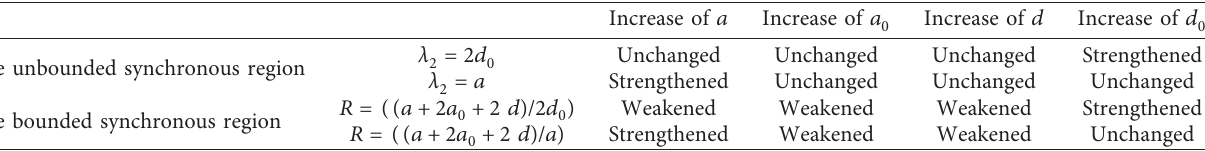
, d, and d of Network I when N is odd. 0 0